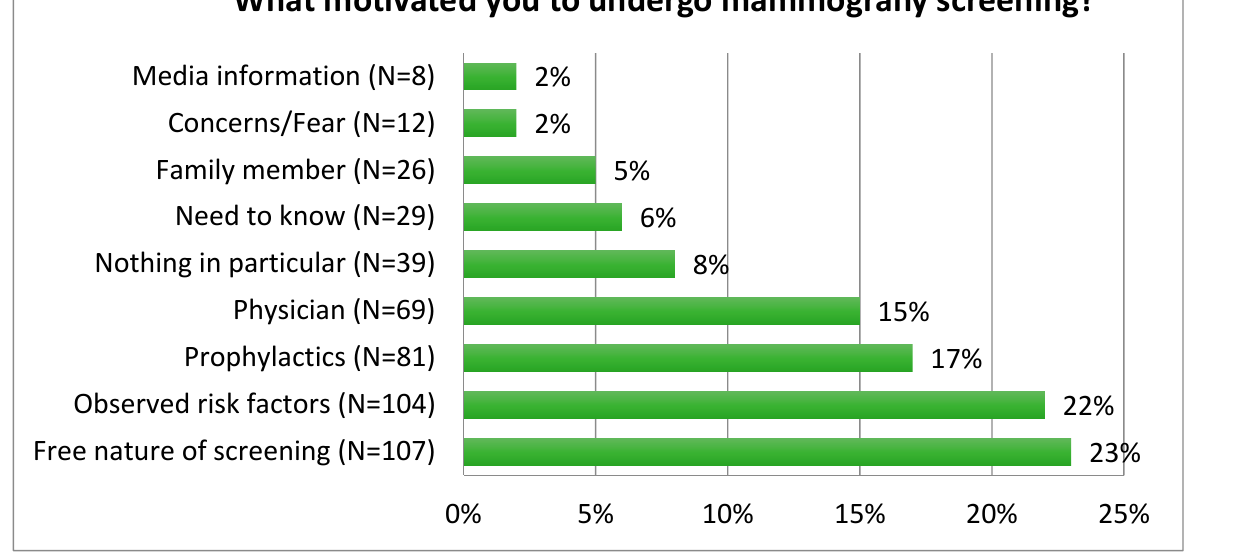
Figure 1. Motives behind undergoing mammography screening.